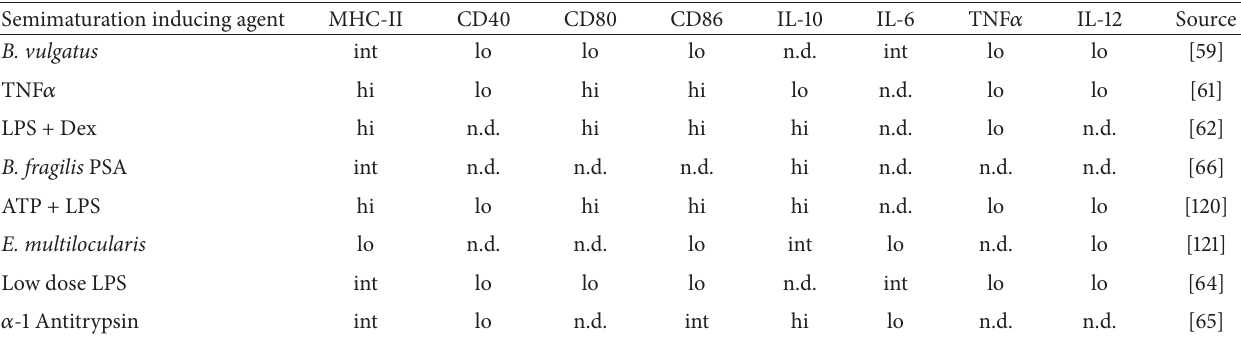
Table 1: Phenotypes of semimature dendritic cells dependent on semimaturation inducing agent. LPS (lipopolysaccharide), Dex (dexameth- asone), and PSA (polysaccharide A); high expression (hi), low expression (lo), intermediate expression (int), and not determined